Question: Summarize what this figure shows in one sentence.
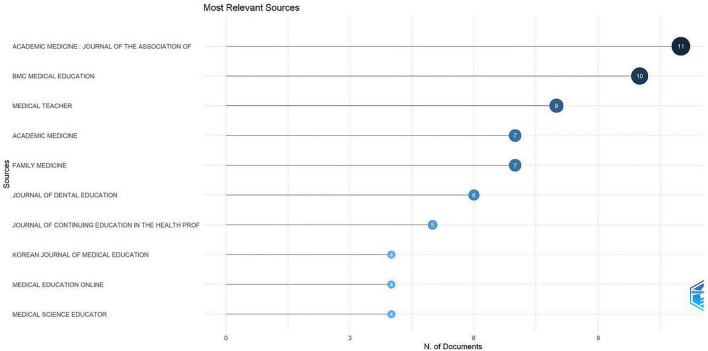
Answer: Most relevant sources. Journals with the highest number of publications in the field, indicating key outlets for faculty development research.